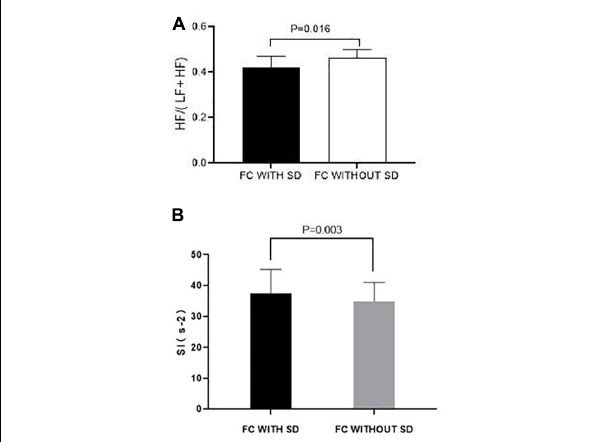
FIGURE 3 | Effects of SD on autonomic function in FC patients. (A) Parasympathetic activity represented as the ratio of HF/(LF + HF) in FC patients with SD was significantly lower than that of FC patients without SD ( P < 0.050). (B) Sympathetic activity represented as the Baevsky Index or Sympathetic Index (SI) in FC patients with SD was significantly higher than that of FC patients with SD ( P <